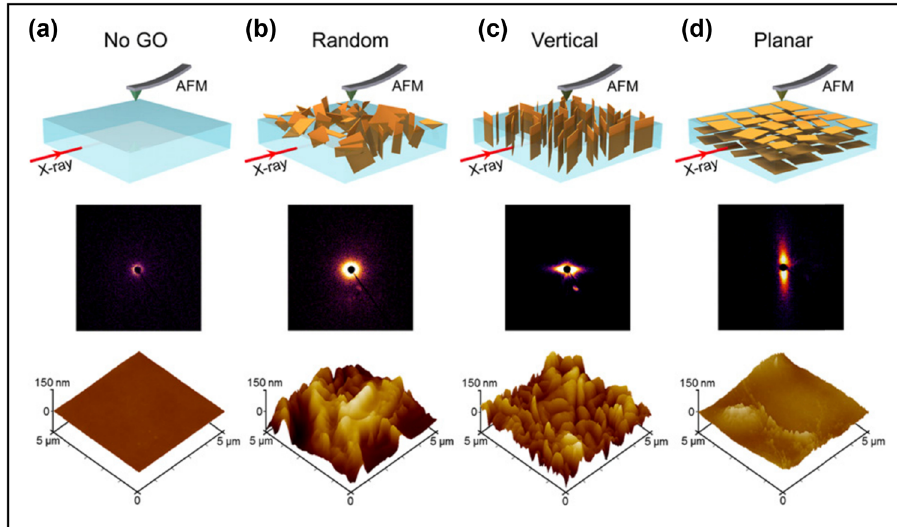
Figure 21: Schematicillustrations,smallangleX - rayscattering ( SAXS ) ,andatomic forcemicroscopy ( AFM ) characterizationofGOcompositetode fi ne its orientation in bulk and on the surface of specimens, respectively. According to the 3D illustration, the X - ray beam is located parallel to the fi lm plane, and the AFM probe is placed above the surface. ( a ) Composite without GO nanosheets displayed minor scattering intensity in the 2D SAXS pattern and smooth surface in the 3D AFM image. ( b ) Composite with randomly oriented GO nanosheets displayed a notable increase to a broad, isotropic halo in the 2D SAXS pattern, and a sharp increase in roughness in the 3D AFM image. ( c ) Composite with vertically GO nanosheets displayed anisotropic equatorial scattering in the 2D SAXS pattern, and vertical alignment in the 3D AFM image. ( d ) Composite with planar GO nanosheets displayed anisotropicmeridional scattering in the 2D SAXS pattern and a smoother surface in the 3D AFM image [ 148 ] . Copyright 2017,